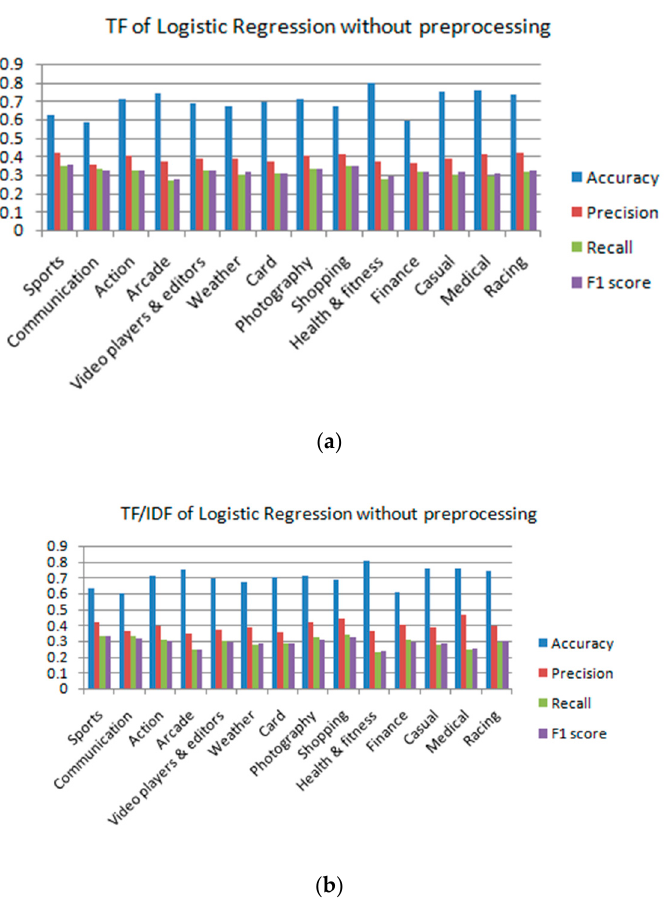
Figure 10. ( a ) Bar-chart visualization of TF logistic regression algorithm based without preprocessing of data; ( b ) bar-chart visualization of TF/IDF logistic regression algorithm based without preprocessing of data.